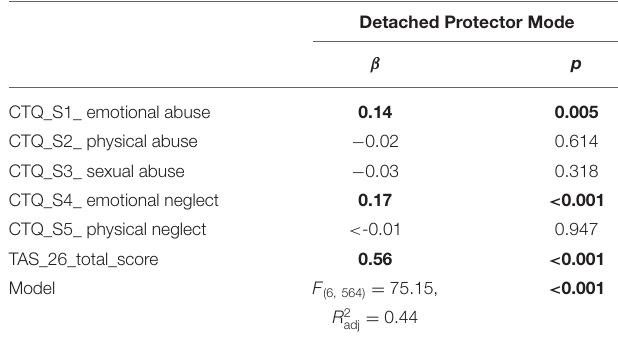
TABLE 4 | Results of the regression analysis on the relation between childhood maltreatment, alexithymia and the SMI detached protector